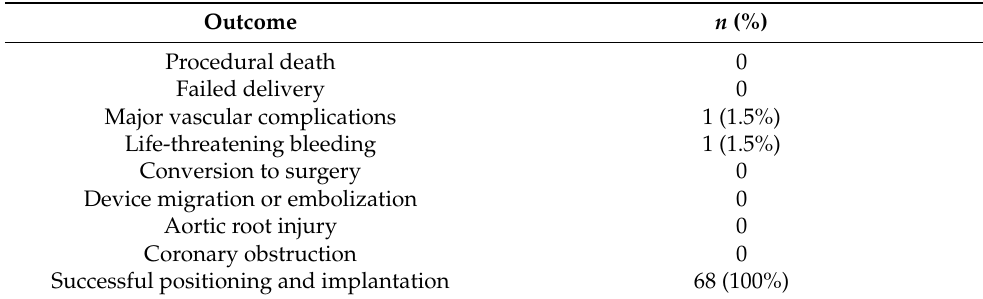
Table 3. Procedural outcome (Technical success (at the exit from procedure room)) of the Myval THV in